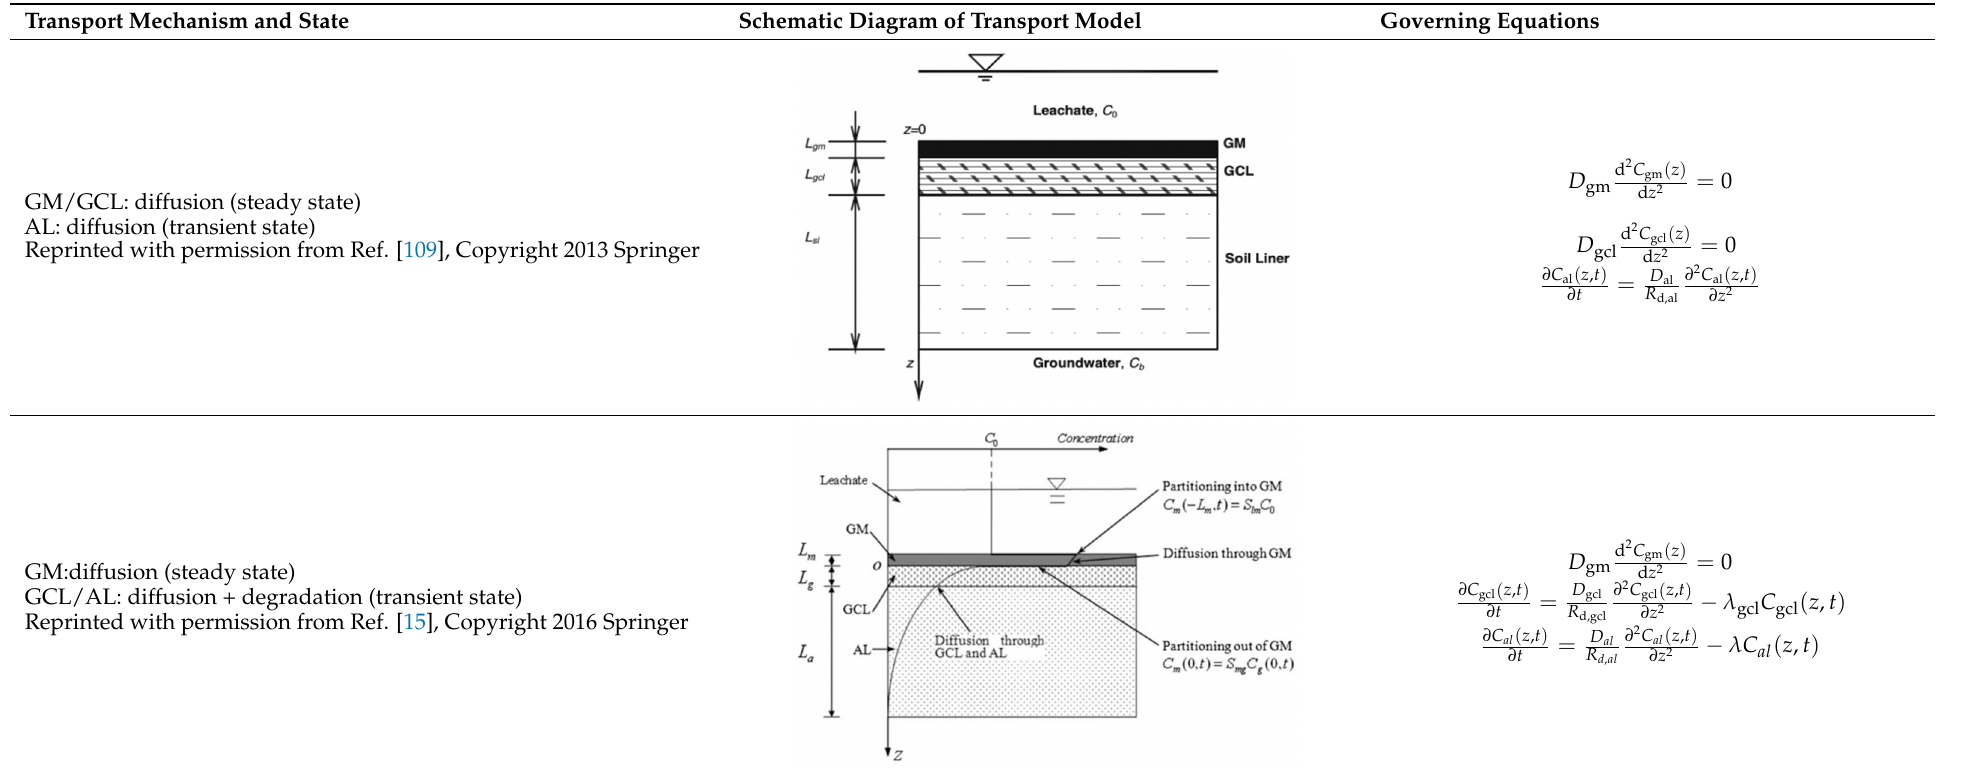
Table 5. Governing equations of the different transport models.